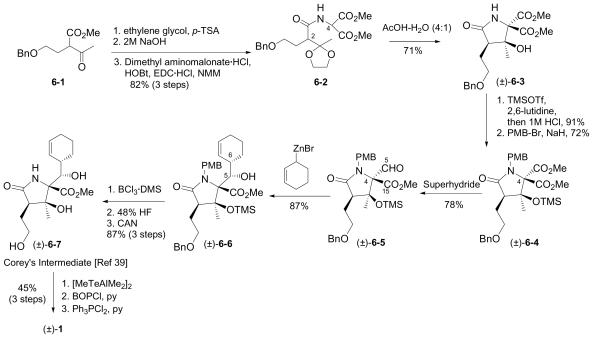
Pattenden and coworkers’ synthesis of (±)-1 [44,104].